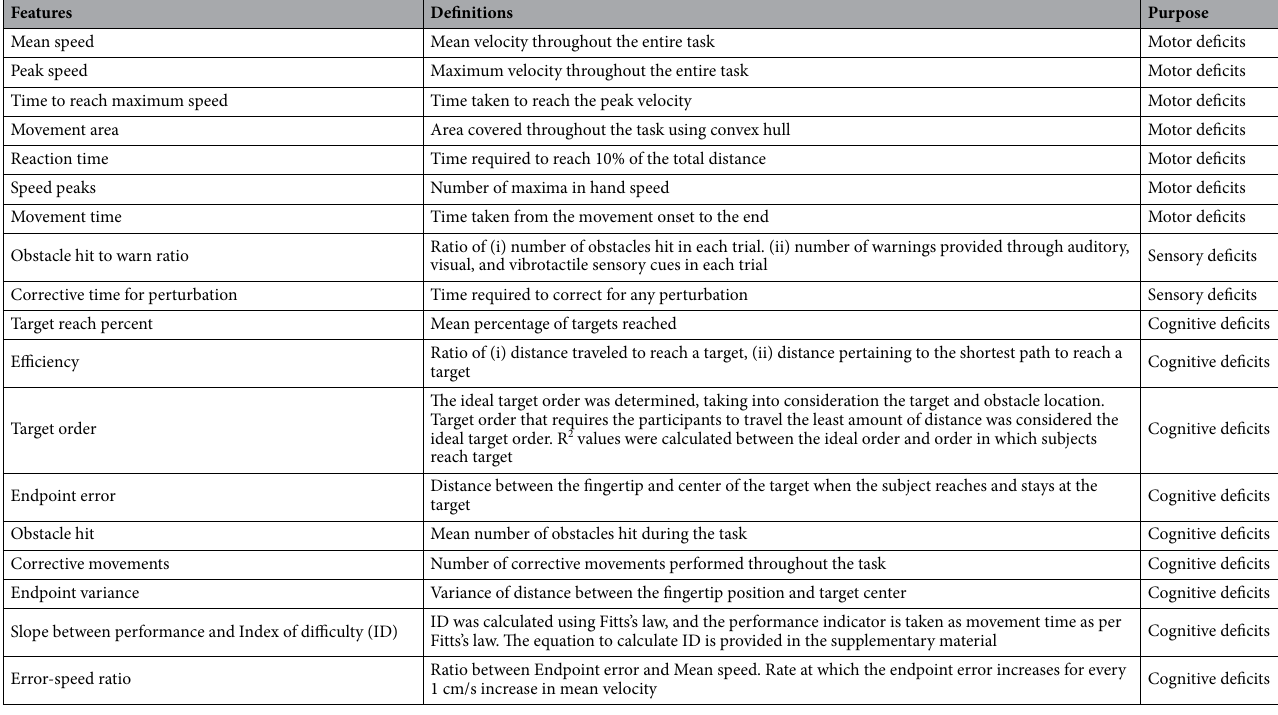
(a) Snapshot of the experiment from the virtual reality software Figure 2. Obstacle avoidance task; the targets are square-shaped, and the obstacles are in the shape of circles and triangles.